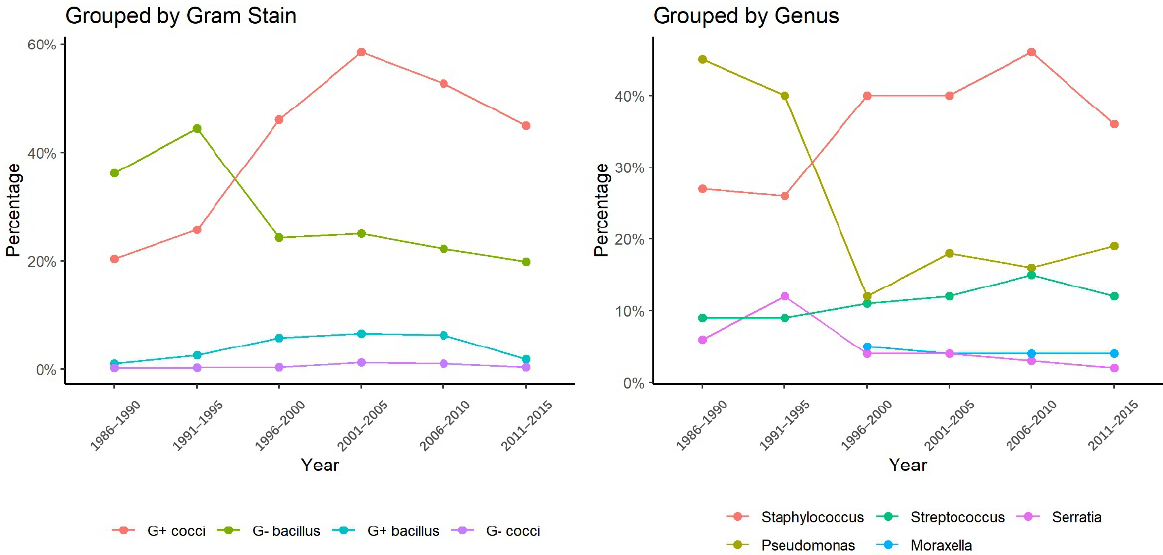
Figure 4. The changing trends of bacterial isolates from corneal lesions in 1990s–2020s.